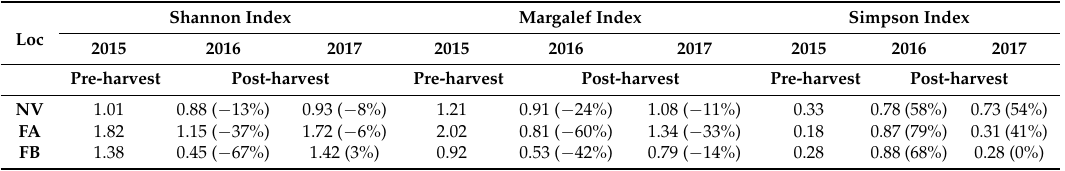
Table 4. Shannon, Margalef, and Simpson indices for each location before (2015) and after (2016 and 2017)